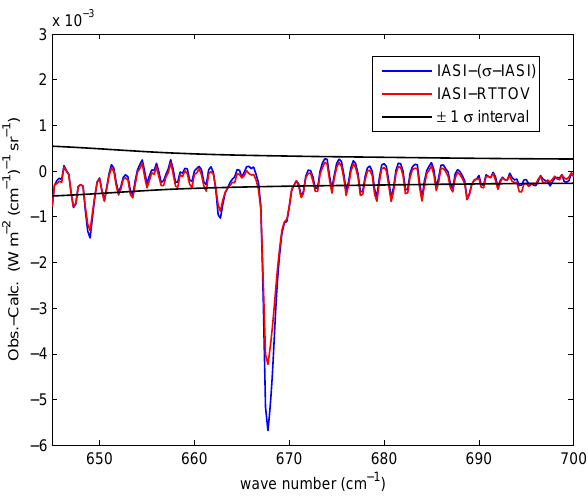
Fig. 8. The interpolation of the temperature profile from the σ -IASI grid to that of RTTOV. This example shows that the interpolation process yields a temperature profile which is slightly colder at the stratopause